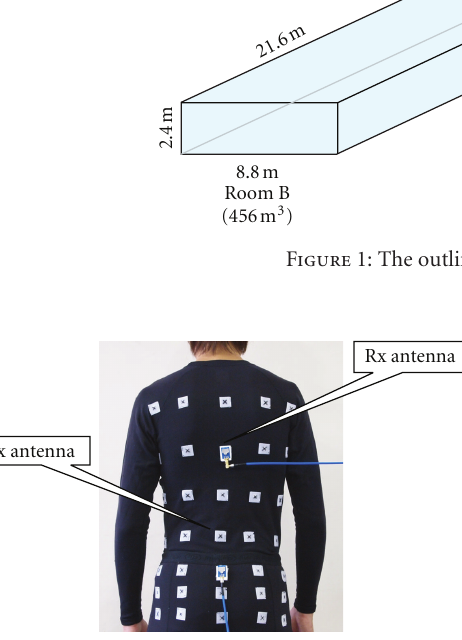
Figure 2: Placement of transmitting and receiving antennas on the body. Rectangular patches on the clothes are fabric hook-and-loop fasteners to fix the antennas.